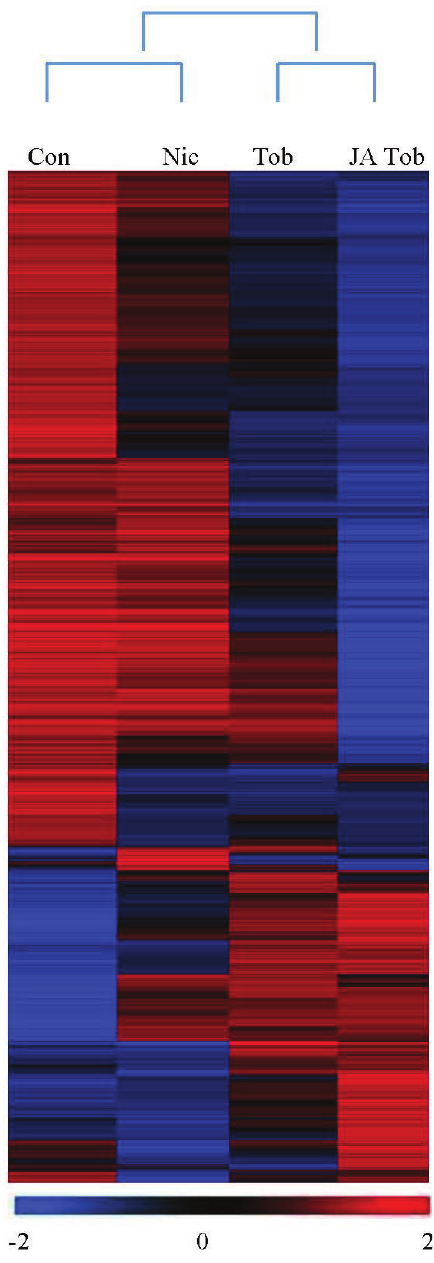
Figure 4. Cluster analysis of caterpillar genes up- and downregulated in response to artificial diet treated with nicotine (Nic), feeding on tobacco plants (Tob) or tobacco plants treated with jasmonate (JA Tob). The dendrogram on top of the clustered heat map illustrates the relationship among the four treatments. Genes upregulated by treatment appear in red (positive log2-ratio values), while those that were downregulated appear in blue (negative log2-ratio values). Each row in the column corresponds to mean of individual genes, and a color scale is presented below the